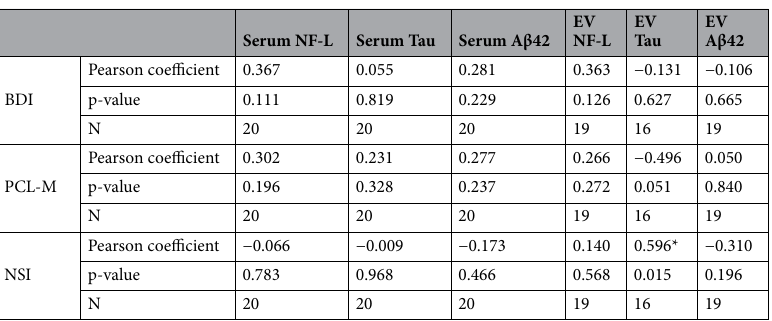
Table 2. Biomarker spearman correlations with psychometric tests. *p < 0.01. BDI Beck Depression Index, PCL-M Post-Traumatic Stress Disorder Checklist-Military, NSI Neurobehavioral Symptom